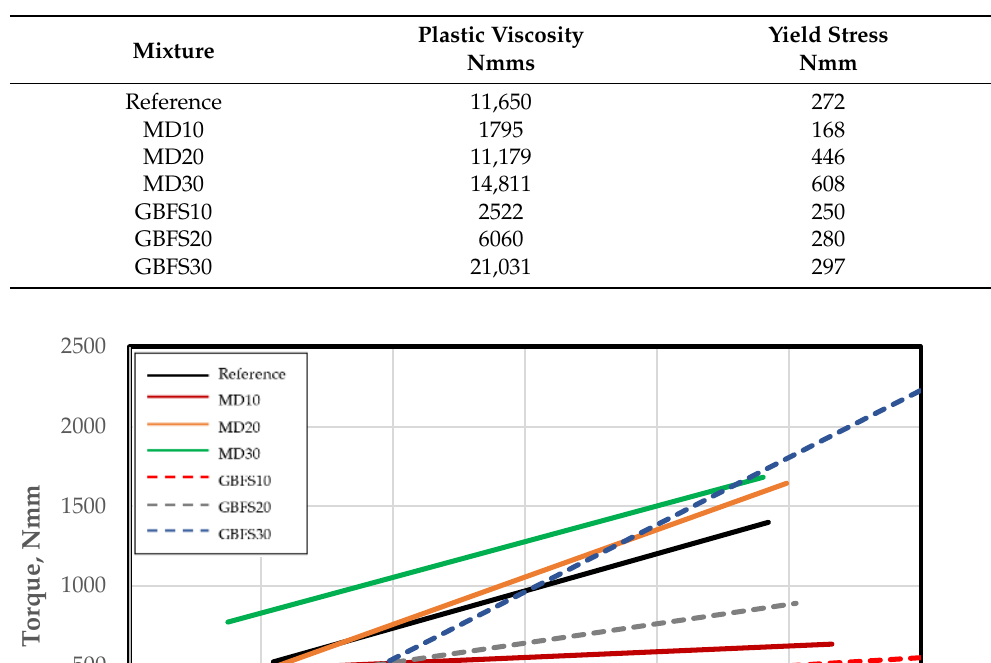
Table 5. Rheological parameters of the SCC mixtures.